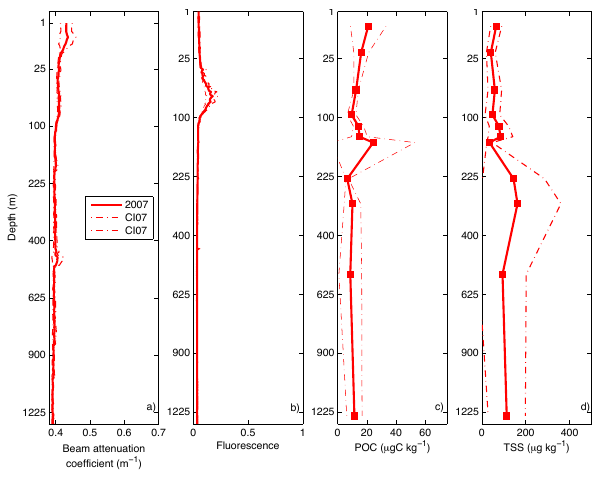
Fig. 6. As in Fig. 2 but for the eastern shelf of the Canada Basin. The upper 1300m are shown to include all attenuation features and bottle samples. This region was sampled only in 2007. The scales on the horizontal axes are half of those in Figs.